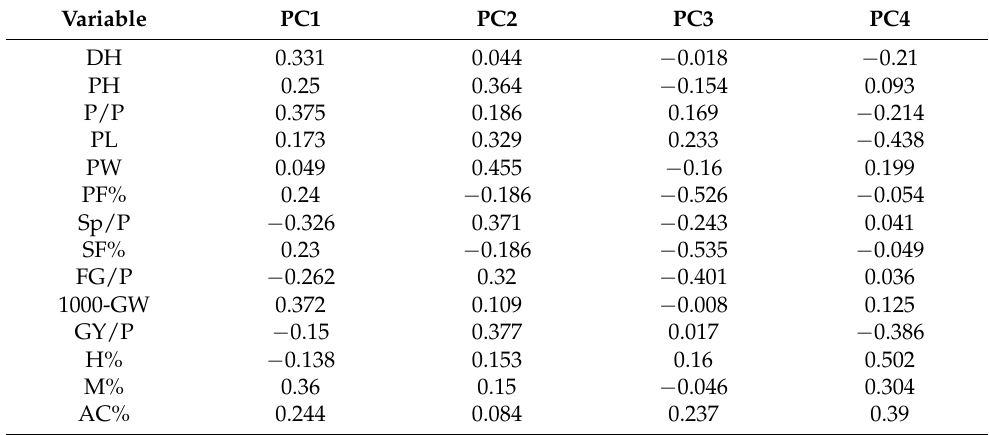
Table 11. The principal component analysis of measured characteristics of twenty genotypes of rice.